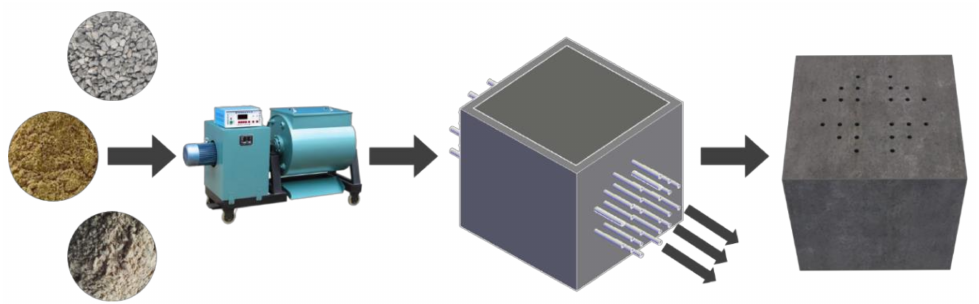
Figure 2. Schematic diagram of the preparation process of